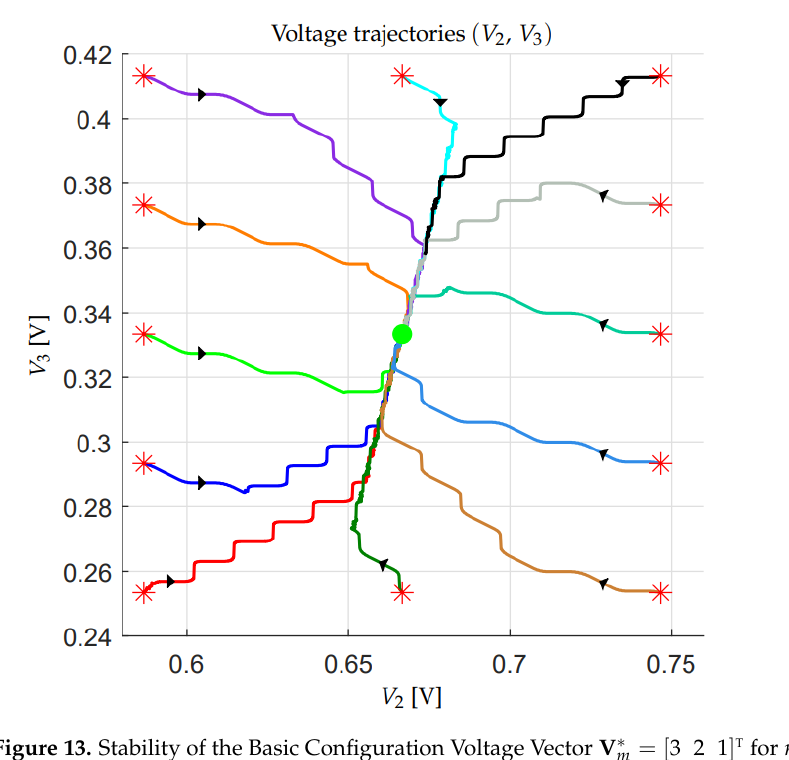
Figure 13. Stability of the Basic Configuration Voltage Vector V ∗ m = [ 3 2 1 ] T for n = 3.